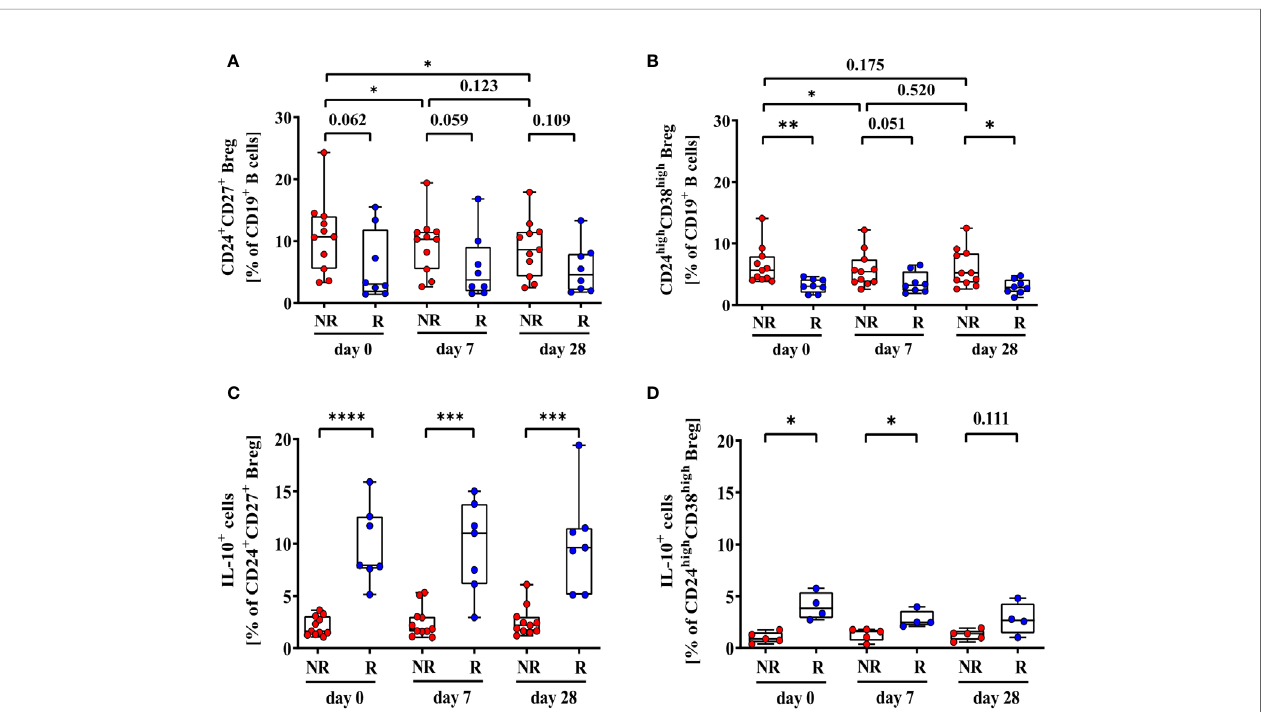
FIGURE 2 | Frequencies of CD24 + CD27 + (A) , CD24 high CD38 high (B) , CD24 + CD27 + IL-10 + (C) , and CD24 high CD38 high IL-10 + Breg (D) of second-generation hepatitis B vaccine non-responders and responders. Depicted are (CpG+P/I)-induced frequencies of CD24 + CD27 + (A) , CD24 high CD38 high (B) , CD24 + CD27 + IL-10 + (C) , and CD24 high CD38 high IL-10 + Breg (D) of second-generation hepatitis B vaccine non-responders (NR, red circles, n = 11) and second-generation hepatitis B vaccine responders (R, blue circles, n = 8) before (day 0) and 7, and 28 days after vaccination with a third- (NR group) or second- (R group) generation hepatitis B vaccine, respectively. The boxes show the median and the 25 th and 75 th percentile. Whiskers indicate the highest and lowest values. Statistical analyses are based either on unpaired Mann-Whitney U tests for the analysis of the NR vs. the R group or on Friedman tests with post Wilcoxon signed rank testing for analysis of the impact of third- and second-generation hepatitis B vaccines within the NR or R group. * p < 0.05; ** p < 0.01; *** p < 0.001; **** p <